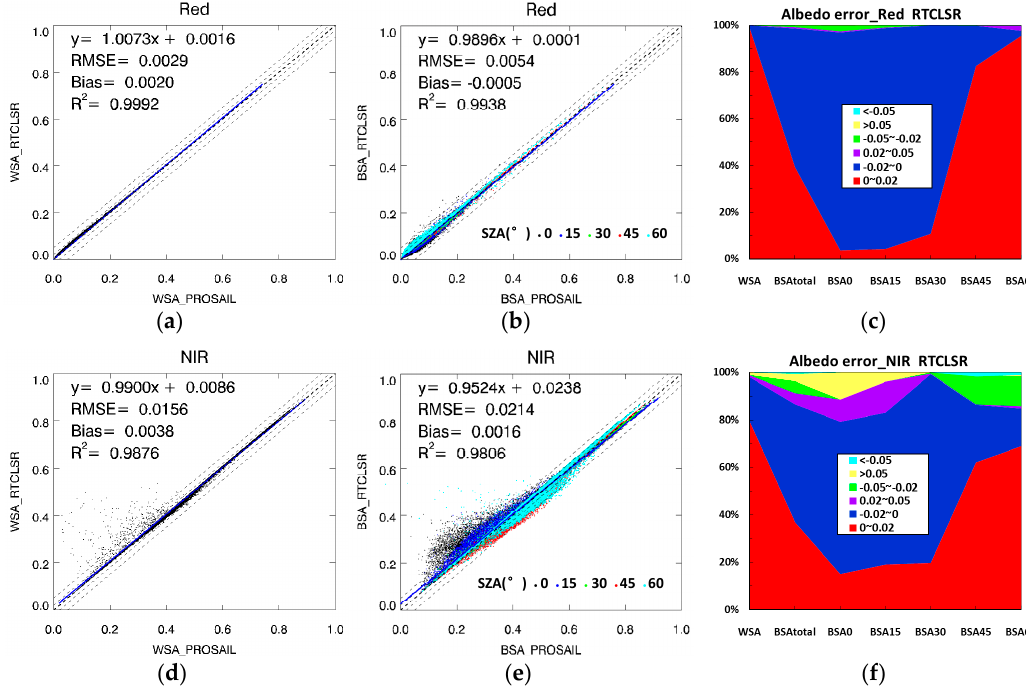
Figure 6. Comparison of simulated and inversion-based albedos for diverse canopies, where the two gray dashed lines show the 0.02 and 0.05 tolerances, respectively: ( a ) WSA comparison in the red band; ( b ) BSA in the infrared band; ( c ) WSA and BSA statistics; and ( d – f ) results corresponding to those in ( a – c ) for the NIR band. Table 4. The albedo deviation percentages between RTCLSR inversion and PROSAIL simulations in different accuracy ranges (%).